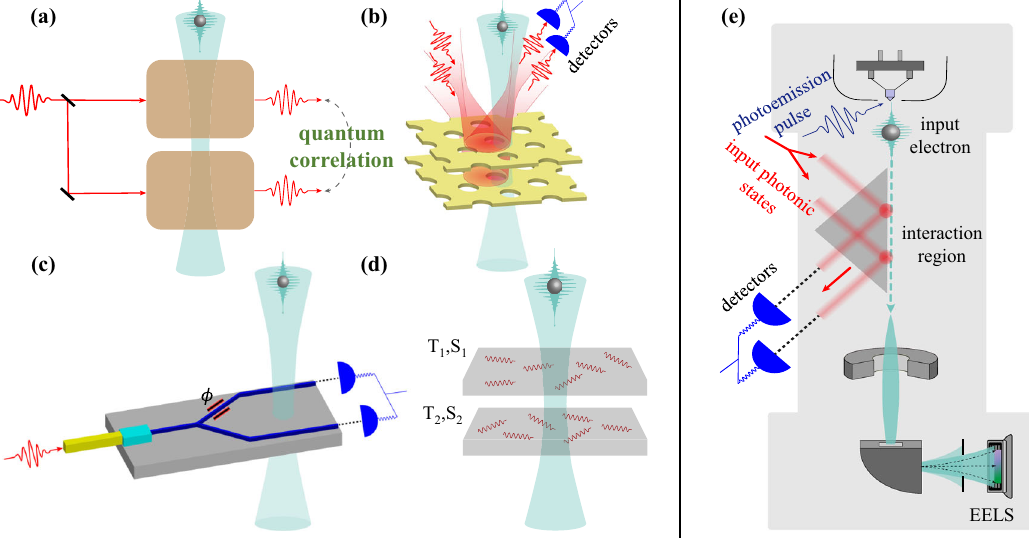
Fig. 1 Free-electron interactions can create quantum correlations in different setups. The general concept ( a ) can be implemented for electron interactions with different systems: photonic crystal cavities ( b ), silicon-photonic waveguides ( c ), and even other types of photonic quasiparticles 57 such as phonons ( d ), which may entangle the temperatures of spatially separated objects. e One speci fi c experimental setup that can demonstrate the general concept is the ultrafast transmission electron microscope (UTEM), where electrons can interact with evanescent fi elds and induce quantum correlations between these fi elds. Here, the two photonic states are created by having a light pulse split into two parts that undergo total internal re fl ection in two locations inside a prism (similar to 59 ). Another relevant scheme was shown feasible in 36 using classical